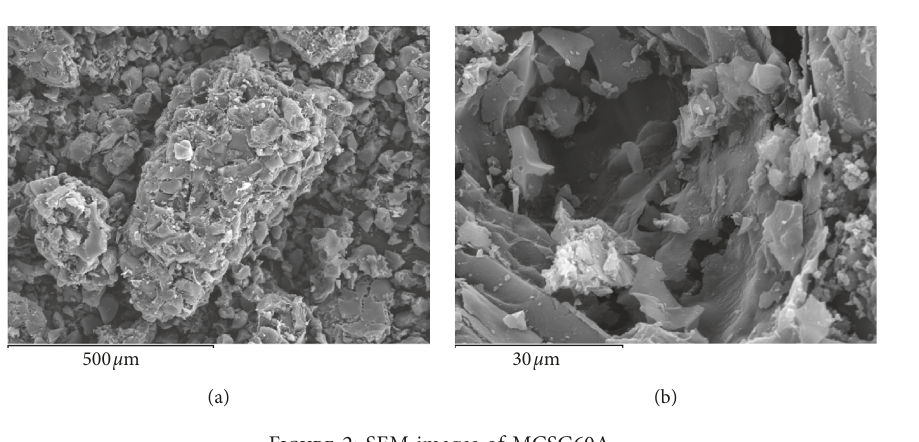
Figure 2: SEM images of